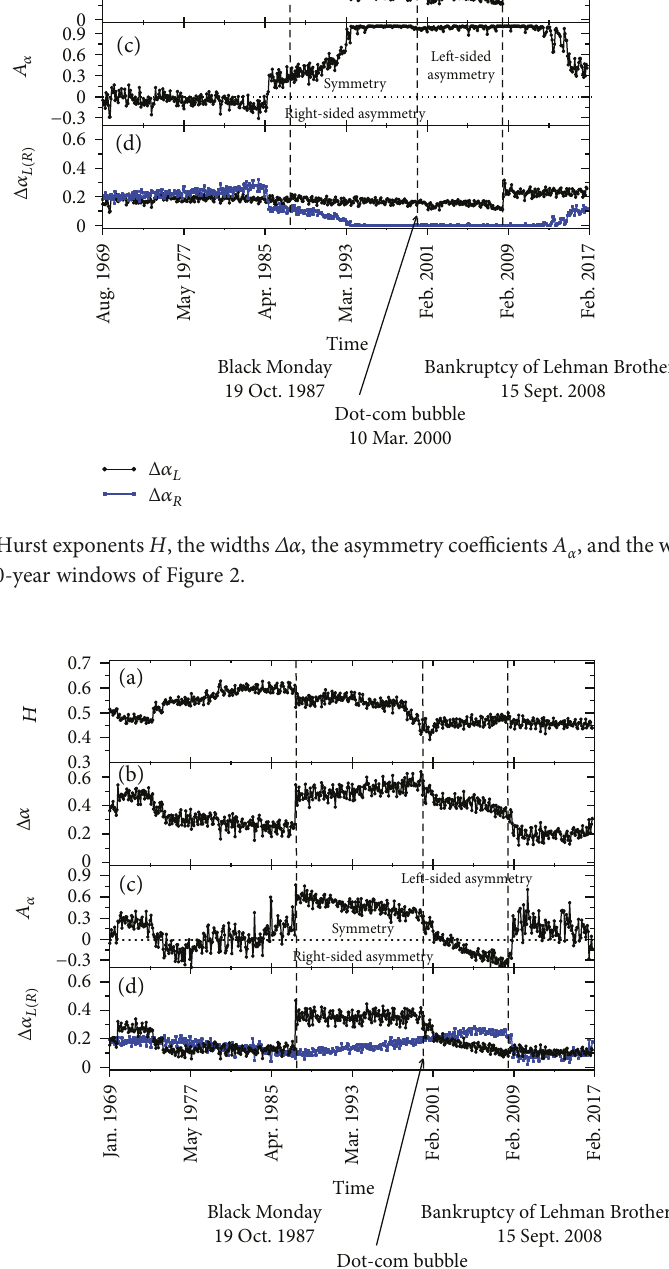
Figure 5: For the NASDAQ, the Hurst exponents H , the widths Δα , the asymmetry coe ffi cients A sequence of multifractal spectra in the 20-year windows of Figure